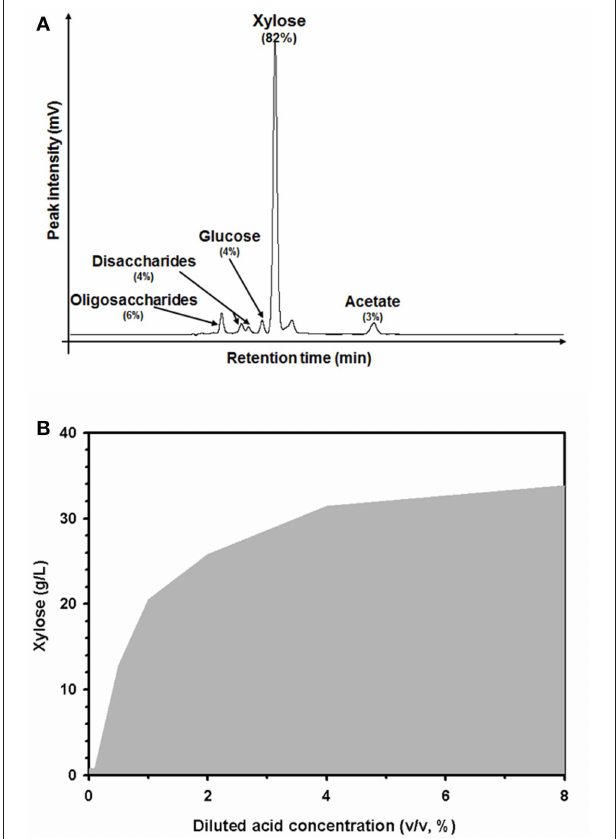
FIGURE 2 | High-performance liquid chromatography (HPLC) profiles of the carbohydrate substances (A) , and xylose extraction profiles in